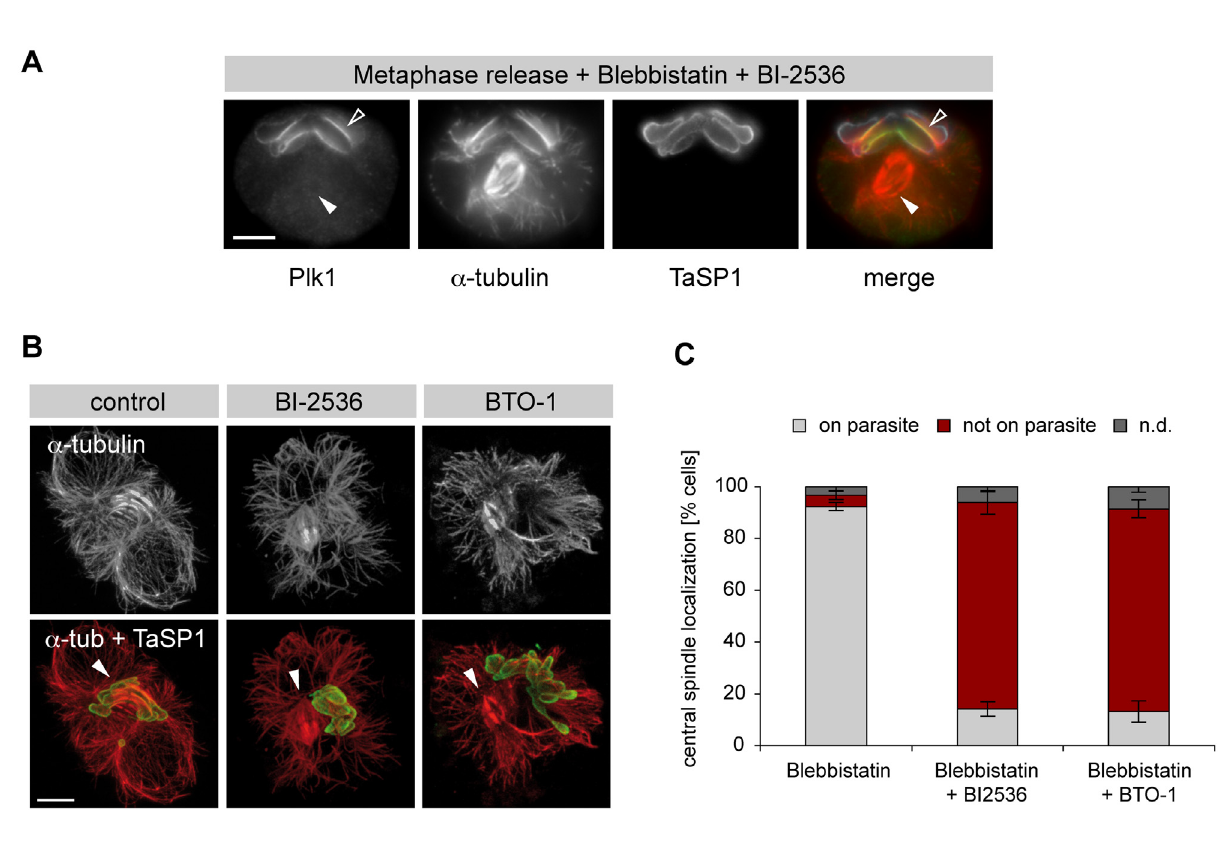
Figure 9. Recruitment of central spindles, but not astral MTs, to the parasite surface requires catalytically active Plk1. The effect of Plk1 inhibition on parasite-central spindle association was monitored by IFM in cells released (80 min) from MG132-induced metaphase arrest. (A) Cells were released from metaphase arrest in the presence of blebbistatin and BI-2536 and stained for Plk1, a -tubulin, and TaSP1. Open arrowheads: parasite-associated Plk1; filled arrowheads: central spindles lacking Plk1. (B) Cells were released from metaphase arrest in the presence of blebbistatin only (control, left panels), blebbistatin and BI-2536 (BI-2536, middle panels), or blebbistatin and BTO-1 (BTO-1, right panels), and stained for a -tubulin and TaSP1. Whole cells are displayed by maximum intensity projection of confocal sections. Arrowheads indicate the position of the central spindle. (C) Cells were released from metaphase arrest in the presence of blebbistatin only, blebbistatin and BI-2536, or blebbistatin and BTO-1. Cells in anaphase and telophase were monitored by IFM for central spindle association with the parasite based on staining of PRC1 and a parasite surface marker. Data represent the mean of three experiments 6 SD with n =100 cells/sample; n.d., not determined (includes all cells in anaphase or telophase that could not be classified). Scale bars represent 5 m